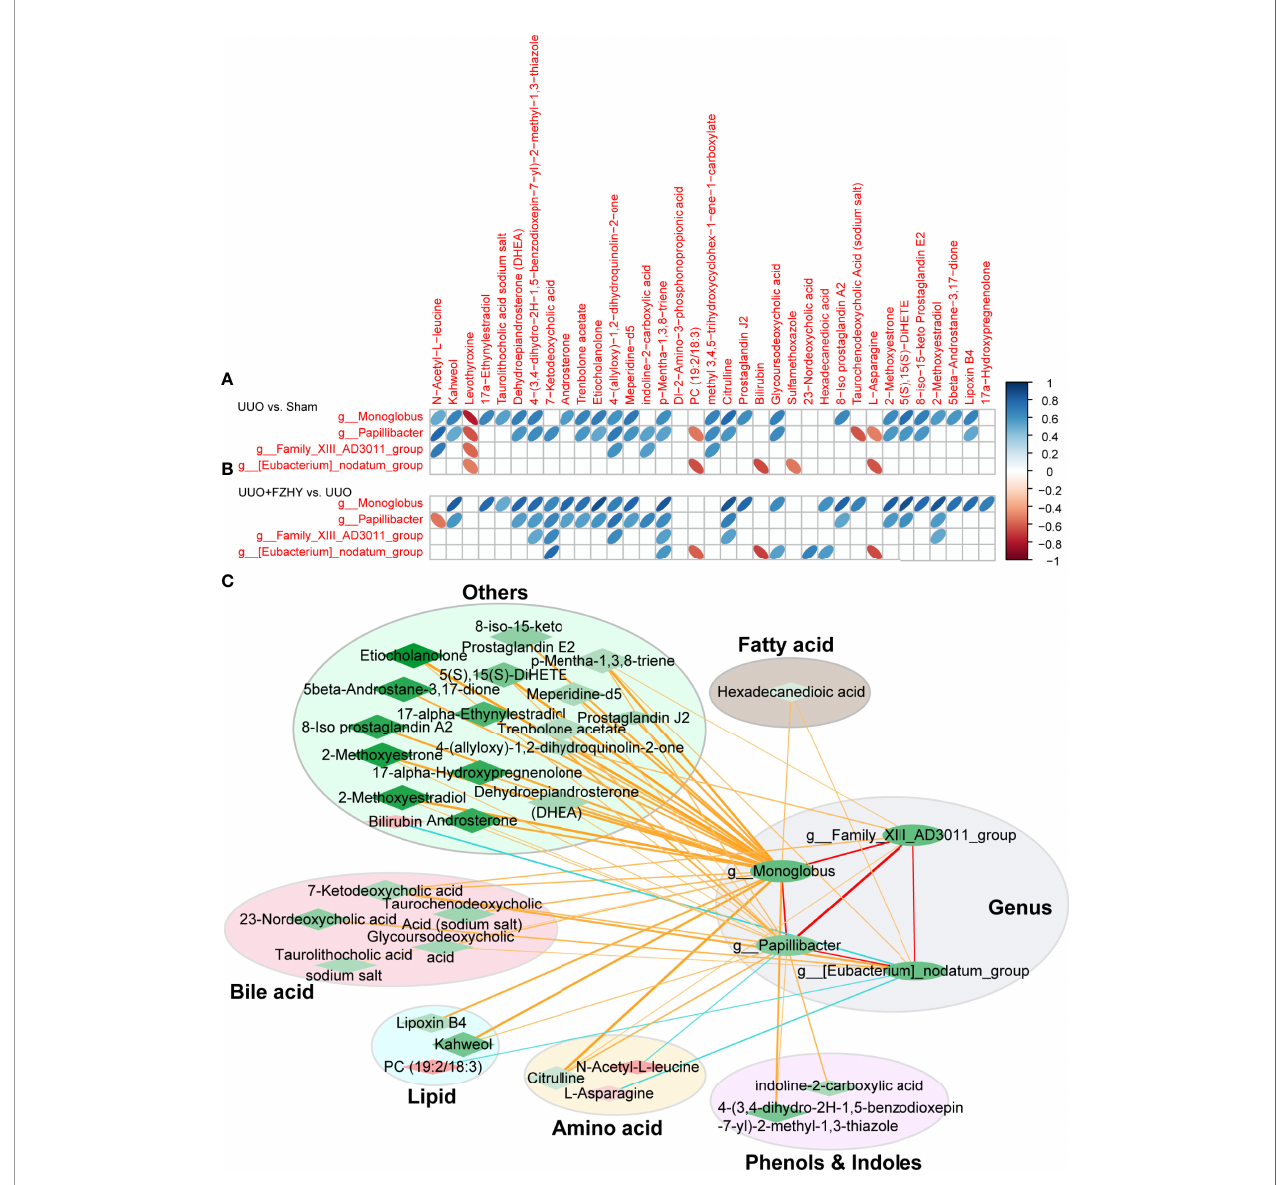
FIGURE 6 | Correlation analysis between differential genus and differential metabolites. The correlation heatmaps for the UUO vs. sham groups (A) and the UUO+ FZHY vs. UUO groups (B) were analyzed by Pearson correlation coef fi cient. The “ blue ” bar represents positive correlation, and the “ orange ” bar represents negative correlation. (C) The correlation network between 4 genus-level bacterial taxa and 31 metabolites by the Cytoscape software. The nodes of the network represent the genera (green ellipse) and the metabolites (red diamond and green diamond). “ Red ” represents upregulation and “ green ” represents downregulation. The node color represents the level of difference (logFC) between the two groups (FZHY vs. UUO), and the darker the color, the greater the difference. The diamond size represents the − log10 ( P _value) of correlation; the larger of the signi fi cance, the higher of the correlation, and vise versa. The edges represent the degree of correlation between the two nodes. The color of the edge represents the correlation between the two; “ yellow ” and “ red ” represent positive correlation and “ blue ” represents negative correlation. The thickness of the edge represents the degree of correlation, and the thicker the edge, the higher the correlation. The metabolites are divided into six categories, namely, bile acid metabolites (light pink ellipse), lipid metabolites (light blue ellipse), amino acid metabolites (light yellow ellipse), phenol and indole metabolites (light purple ellipse), fatty acid metabolites (light gray ellipse), and other metabolites (light green